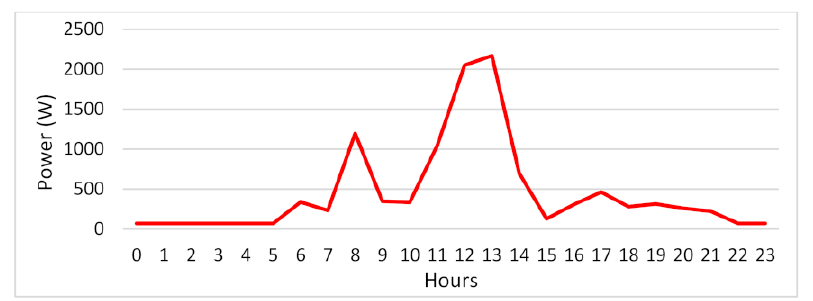
Figure 5. Hourly load curve.